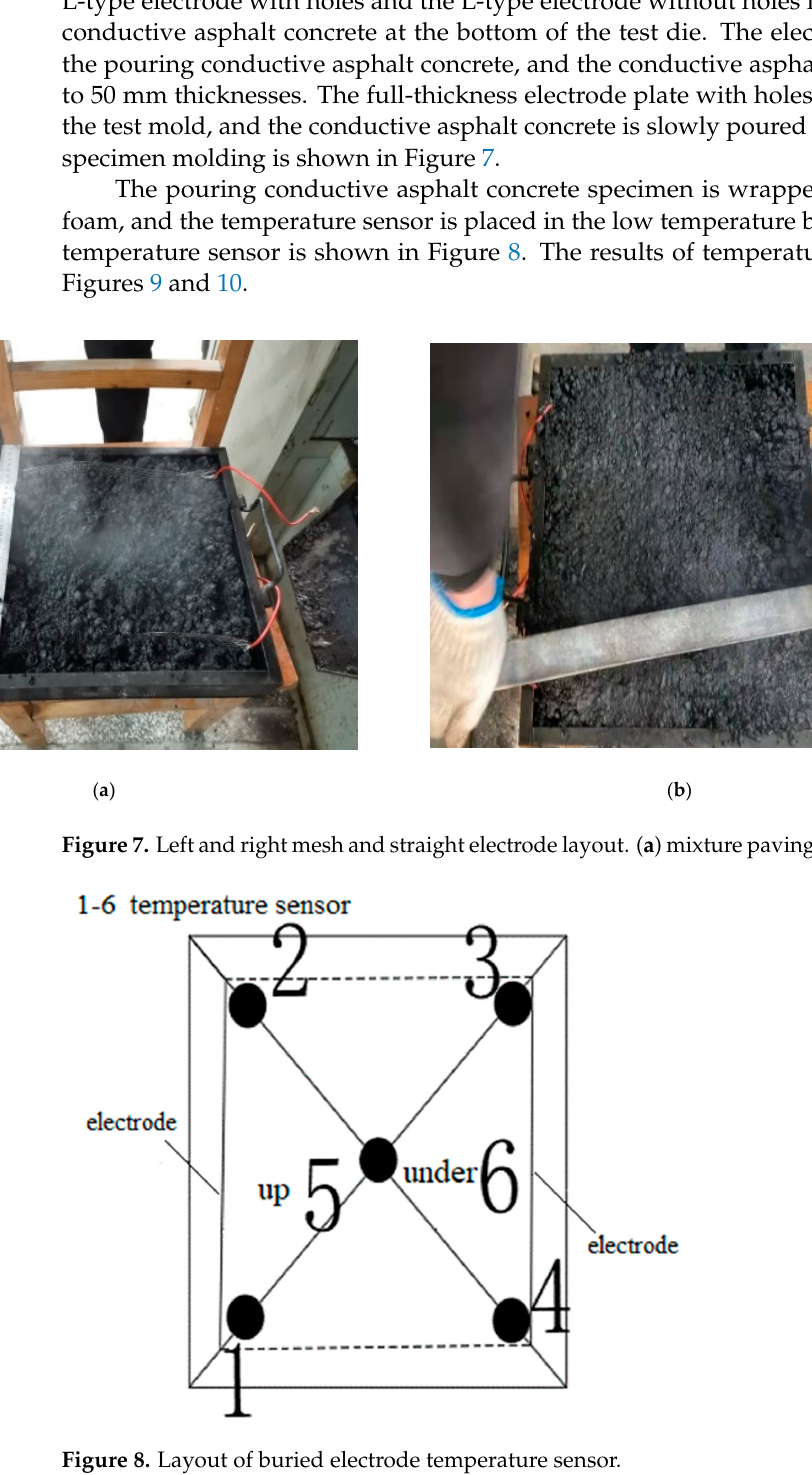
Figure 8. Layout of buried electrode temperature sensor.